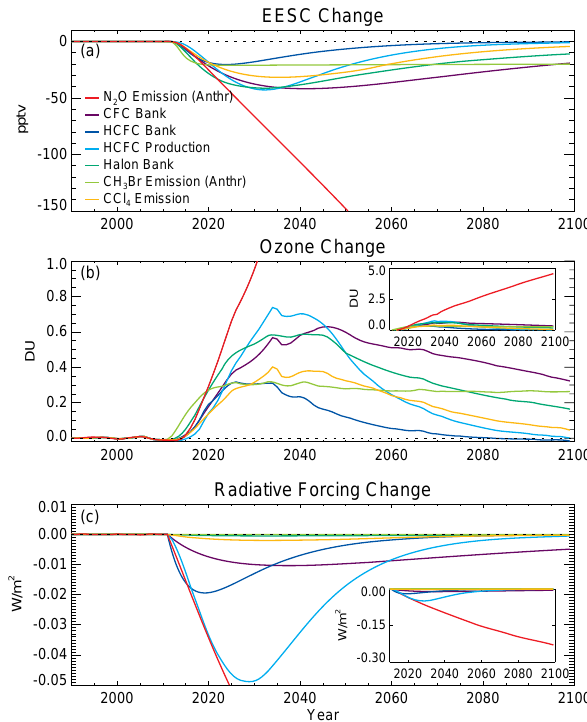
Fig. 4. Changes in (a) EESC, (b) total ozone from the GSFC model, and (c) radiative forcing, resulting from the various N 2 O and ODS reduction cases in Table 1. The responses for the N 2 O case (red) appear almost linear in the main panels because of its long lifetime and because future anthropogenic N 2 O emissions vary little through 2100 in the assumed A1B scenario. The insets in panels (b) and (c) have increased vertical scale ranges so the entire N 2 O change is visible through 2100. EESC is calculated assuming an average age of 3.0y with an age spectrum width of